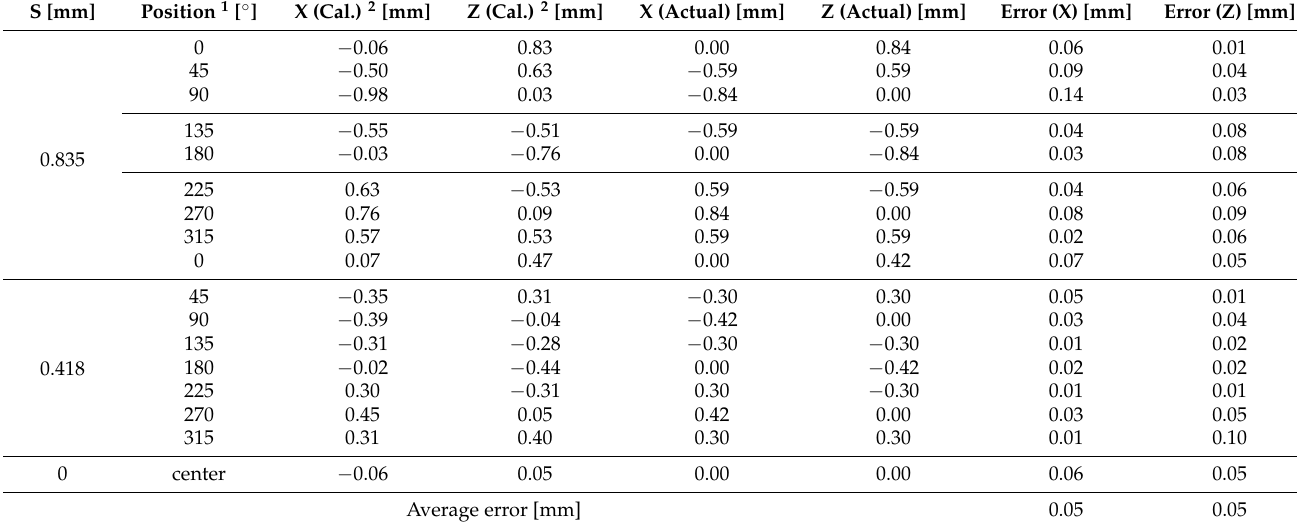
Table 1. Actual and calculated positions of the 17 points that were used as the center of the connect- ing part.